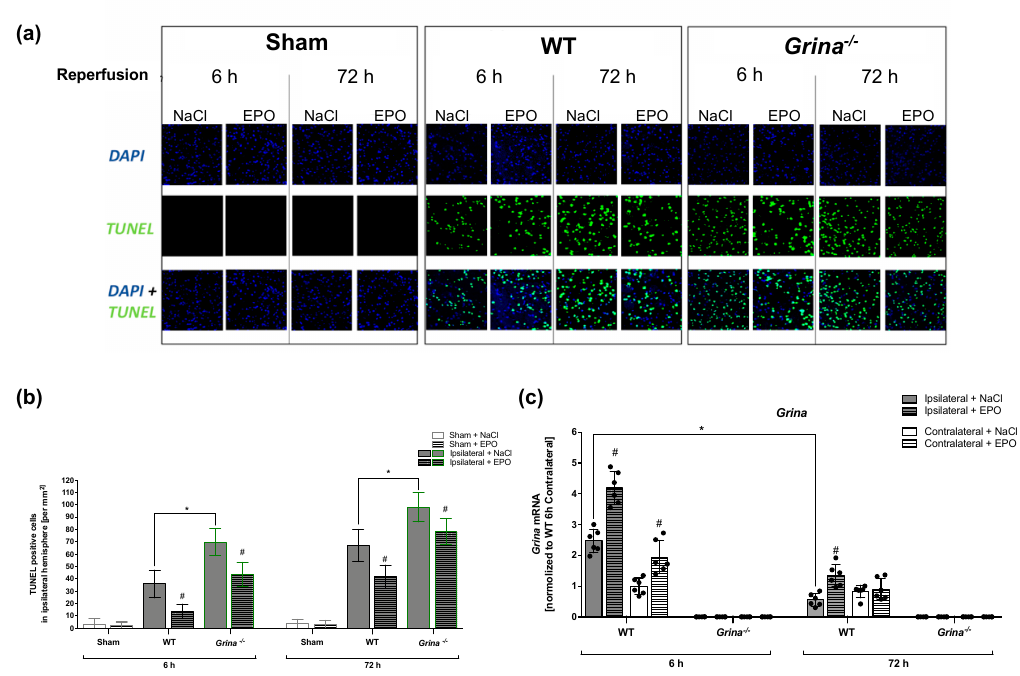
Figure 3. EPO administration abrogates stroke induced apoptosis after both 6 and 72 h of reperfusion ( a ) Representative images of TUNEL positive cells in paraffin-embedded coronal ipsilateral brain sections of mice sacrificed 6 and 72 h after 30 min of tMCAo or sham surgery are shown. Green fluorescence shows TUNEL-positive cells and blue fluorescence indicates DAPI staining of the nuclei. ( b ) Quantification of TUNEL-positive cells in all genotypes and treatment groups after 6 and 72 h of reperfusion is shown. Six ipsilateral brain slices per mouse (Bregma 0 ± 1 mm) with 12 × 0.01 mm 2 grids per slice were counted by two individual investigators in a blinded manner ( n = 4 animals). ( c ) Grina mRNA levels in the peri-infarct zone and the corresponding contralateral hemisphere after 30 min of tMCAo followed by 6 and 72 h of reperfusion are shown ( n = 6 animals). Bars represent means ± SD. * p < 0.05 intergroup comparison, # p < 0.05 EPO treatment compared to the vehicle group. GRINA-deficiency (68.04 ± 13.47 per mm 2 ) doubled the number of apoptotic cells 6 h after